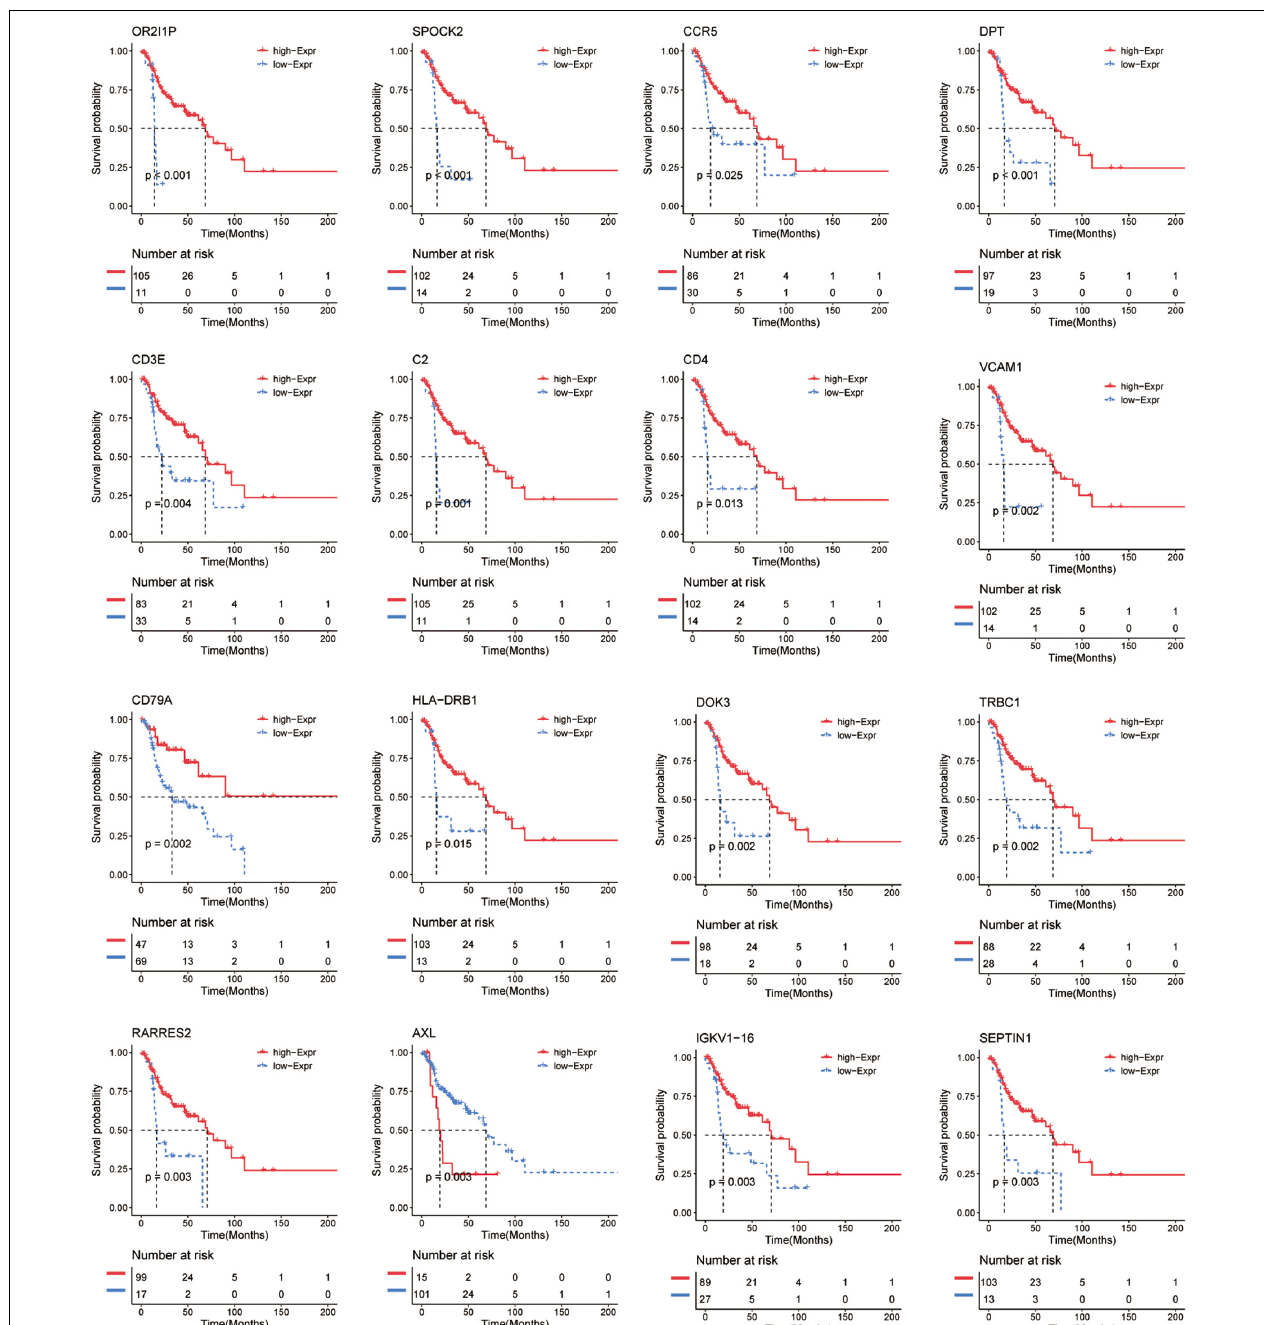
FIGURE 5 | Kaplan–Meier survival curve shows the survival analysis of immune-related genes in recurrent HNSCC. The expression level of 16 immune-related genes to affect the overall survival are selected randomly, and compare the overall survival of the high and low gene expression groups. The red and blue dashed lines represent the upper and lower limits of the 95% confidence interval for gene expression, respectively.